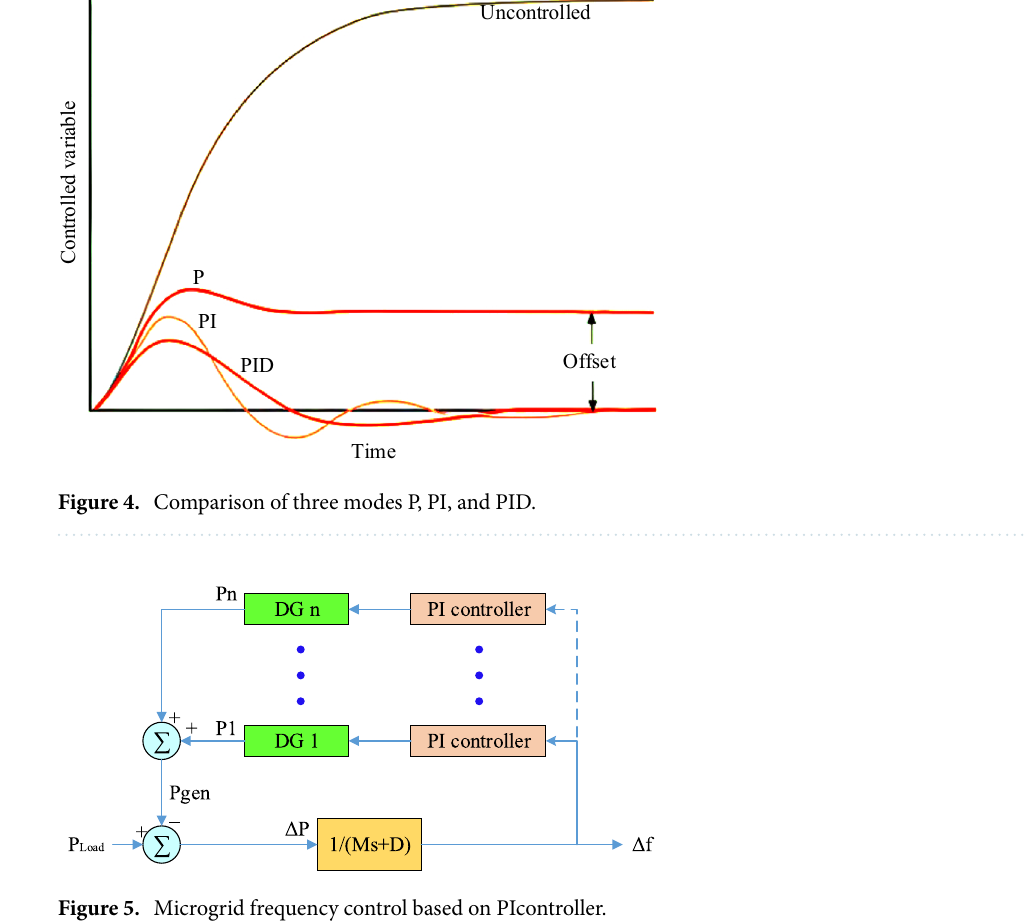
Figure 5. Microgrid frequency control based on